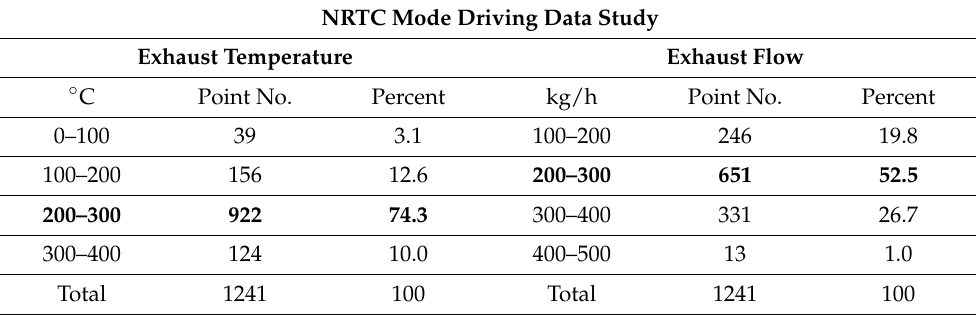
Figure 5. Operating points of the NRTC mode: exhaust temperature vs. exhaust flow rate. Table 1. Statistical analysis of NRTC mode: numbers and percentage of temperature and flow